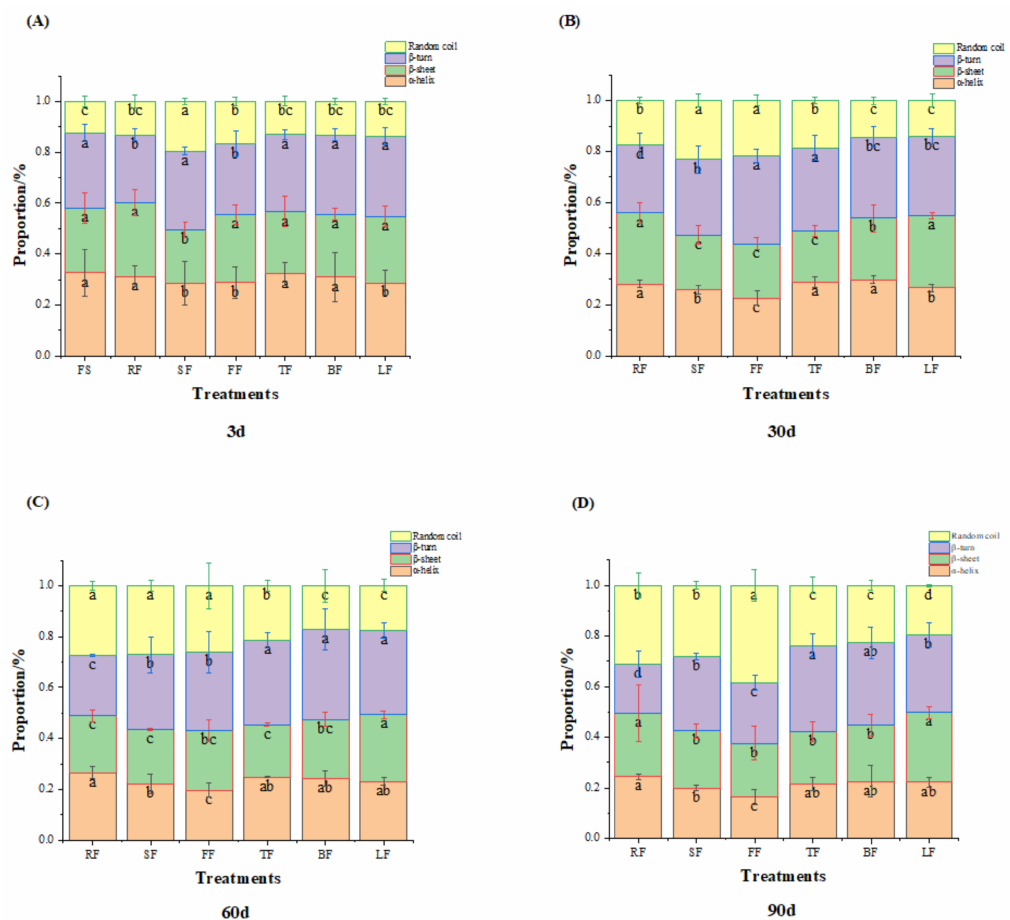
Figure 8. Change in secondary strucure content of cuttlefish during storage at − 18 ◦ C by different freezing methods. Differ- ent the superscript letters (a–d) indicates a significant difference between treatment and control at p ≤ 0.05. ( A – D , represent the samples stored for 3 d, 30 d, 60 d, 90 d, respectively; FS represents fresh